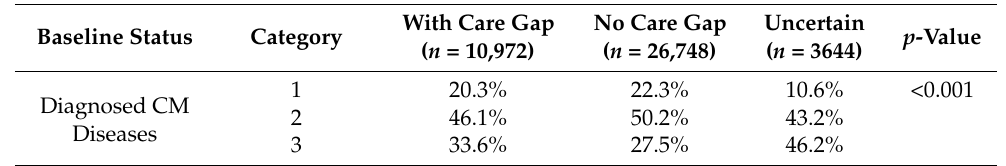
Table A3. Demographic and clinical characteristics of primary care patients 35+ years old who are included in care gap analysis for dyslipidemia in Table